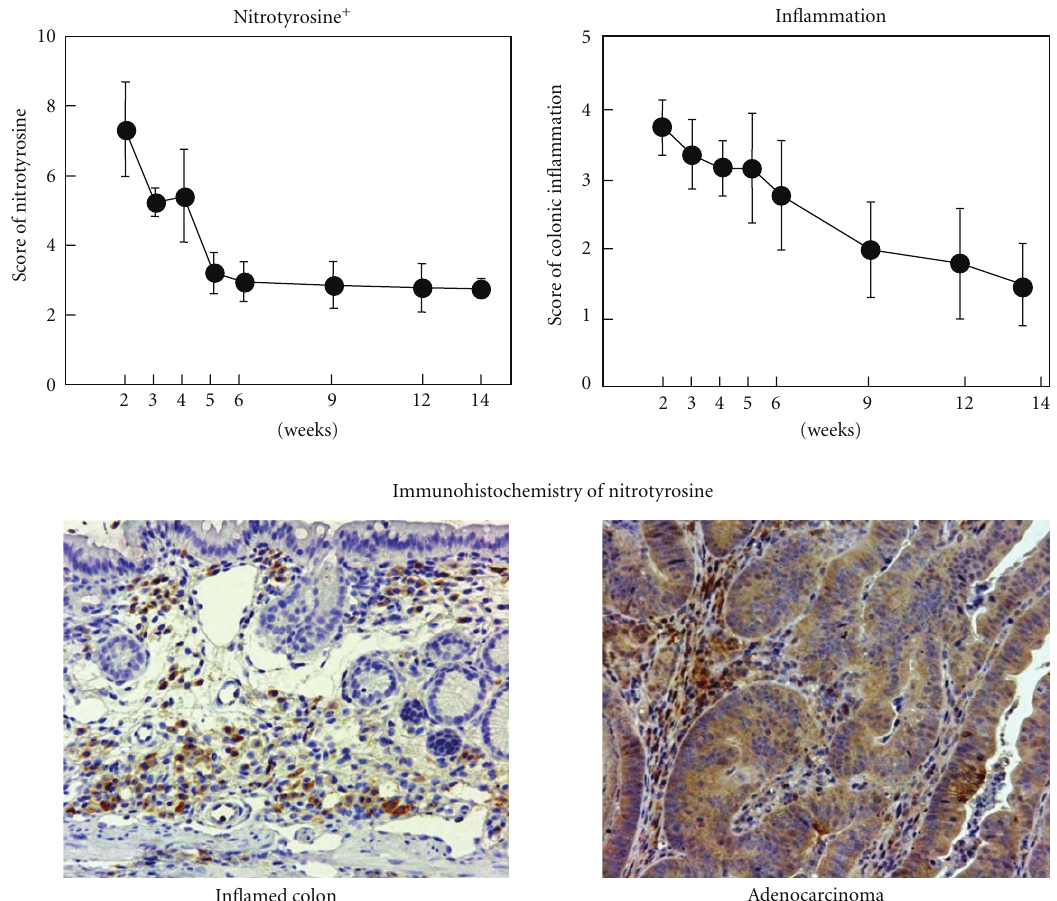
the AOM/DSS-induced colorectal carcinogenesis was as follows: Balb/c > C57BL/6N (cid:3) C3H/HeN = DBA/2N (Fig- ure 16). The sensitivity was in relation to the nitrotyrosine- positive score estimated by immunohistochemical analysis, suggesting the importance of nitrotyrosine in the AOM/DSS- induced colorectal carcinogenesis